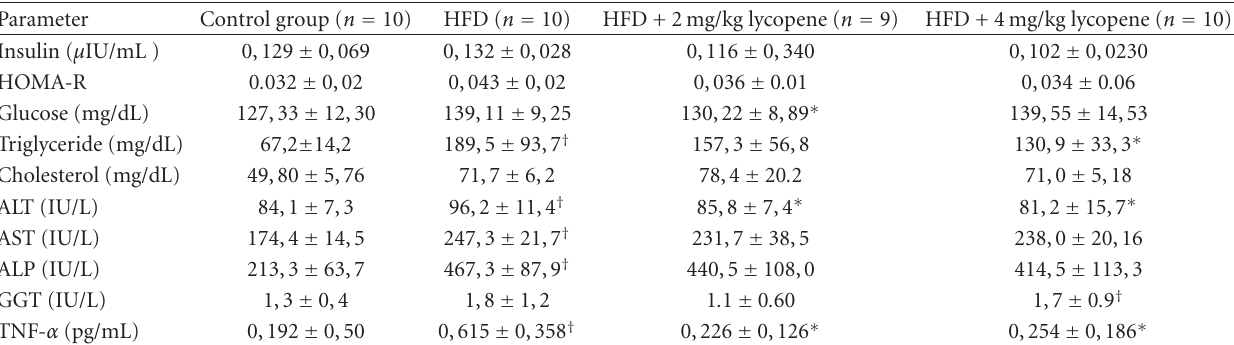
Table 2: The e ff ects of lycopene on serum parameters in